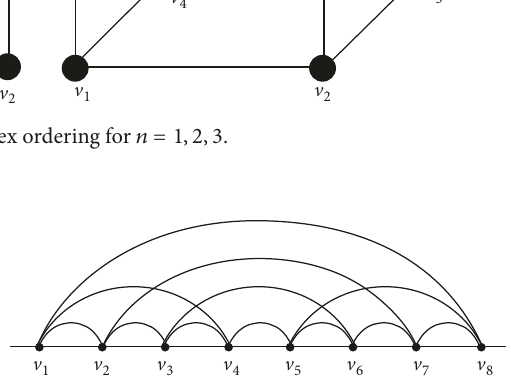
Figure 3: The 2-page drawing of 𝑄 3 with fixed vertex